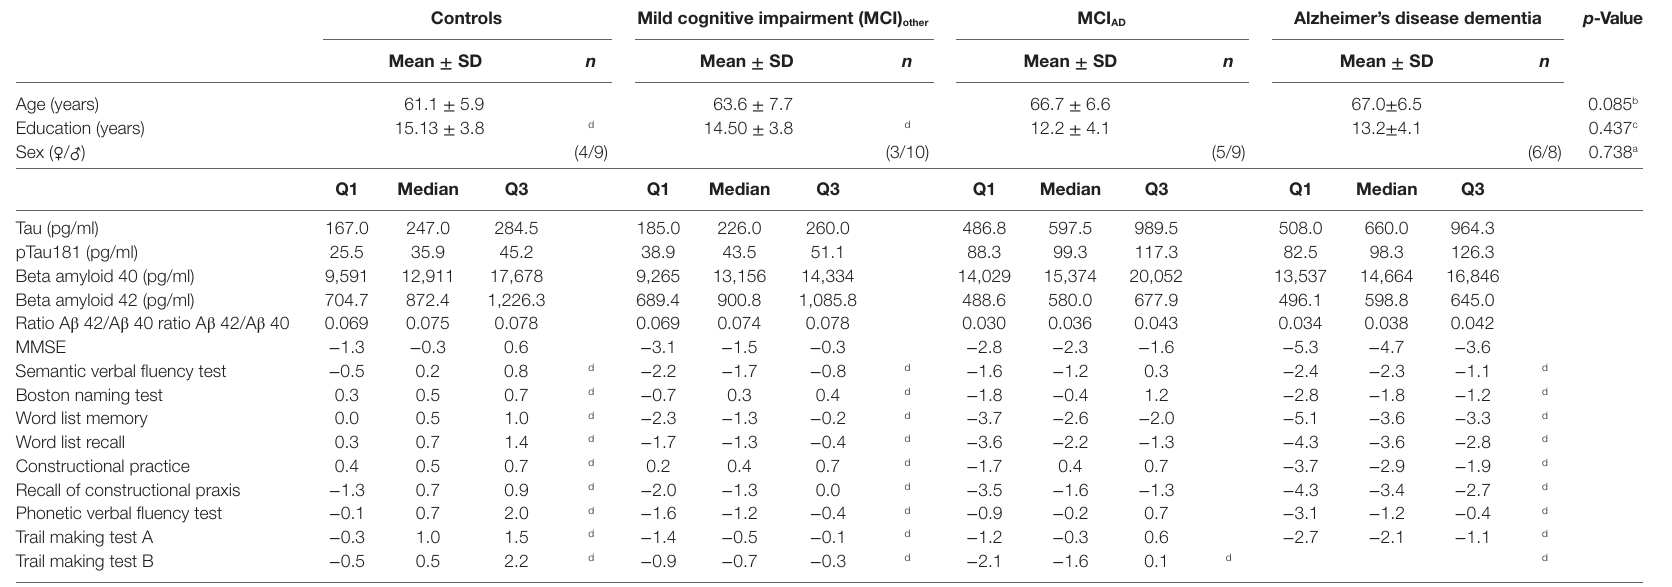
TaBle 1 | Clinical data including cerebrospinal fluid biomarkers and z -scores of the CERAD-NB + of the investigated groups.